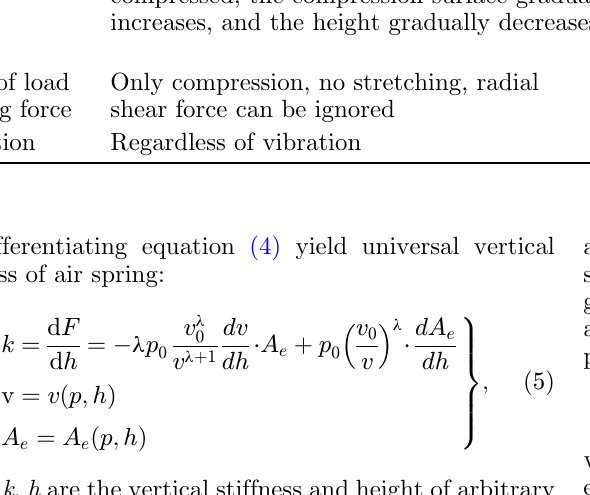
assembly height h , and count of chambers n . Each surface